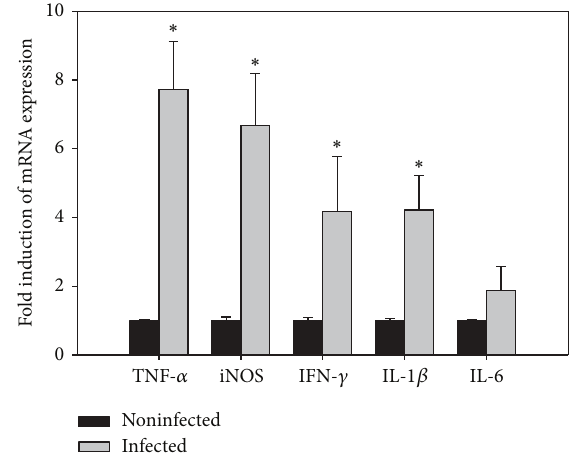
Figure4:QuantitativeRT-PCRanalysisofTNF- 𝛼 ,iNOS,IFN- 𝛾 ,IL- 1 𝛽 and IL-6 in the jejunum. Expression was analyzed in noninfected and infected mice on day 5 p.i., normalized to 18S rRNA signals, and relative expression is given as fold increase compared to the non- infected control mice. Values are means ± SD. ∗ Significant change at 𝑃 < 0.01 with respect to non-infected